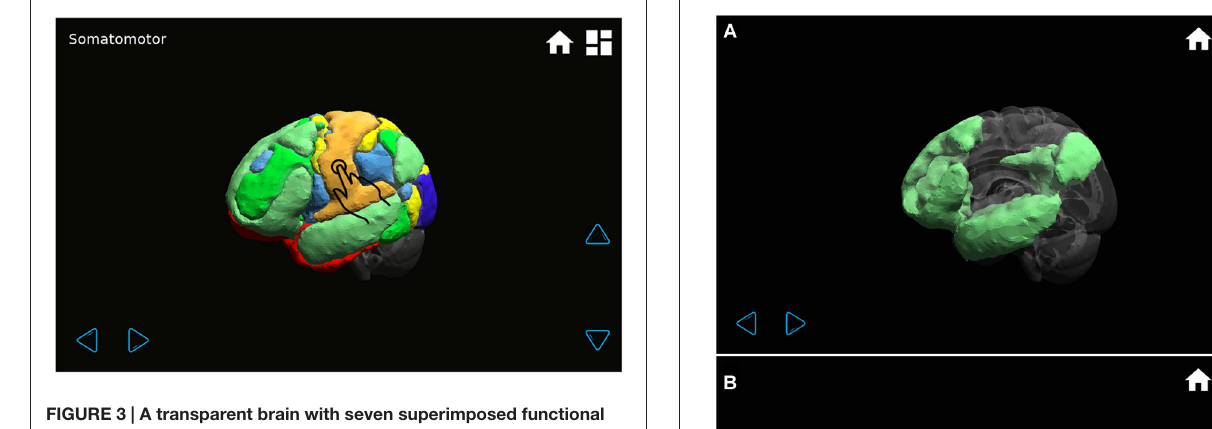
FIGURE 3 | A transparent brain with seven superimposed functional connectivity networks is shown by touching the “All Networks” button (Figure 2). By pressing each network, its name will appear in the upper left-hand corner. The brain can be rotated by pressing the four light blue arrows.